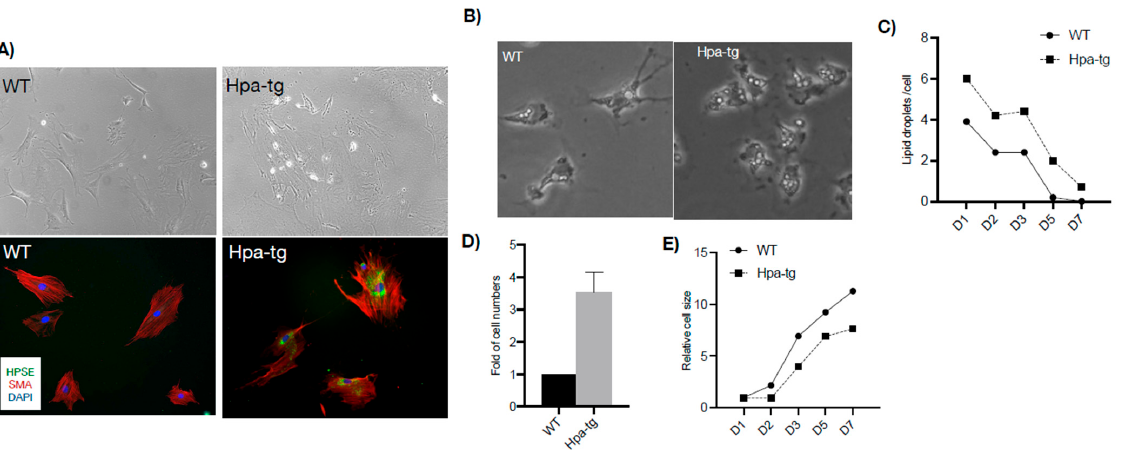
Figure 8. Stellate cells. ( A ) Phase contrast microscopy of cells cultured for 2 weeks (upper panels) and immunostained for alpha-smooth muscle actin (SMA, red) (lower panels), indicating differentiation of stellate cells to myofibroblasts. Heparanase (HPSE, green) was detected only in the Hpa-tg stellate cells. ( B ) Phase contrast microscopy and quantification ( C ) of oil droplets in WT and Hpa-tg stellate cells. Data are average numbers of at least 35 cells per group. ( D ) Relative number of stellate cells isolated from Hpa-tg and WT livers. Data are the average of 3 independent experiments (3 mice per group in each experiment). Naïve WT value was set arbitrarily to a value of 1. ( E ) Cell